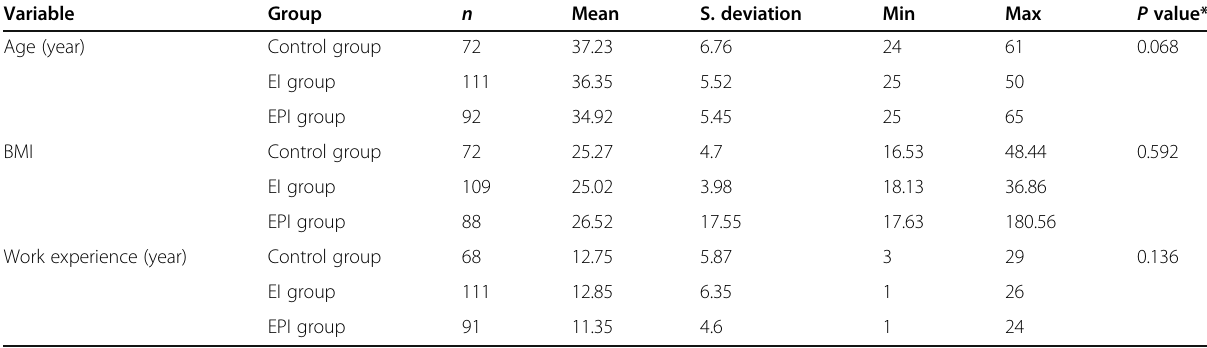
Table 1 Demographic characteristics of employees in a large Iranian Bank by study groups Variable Group